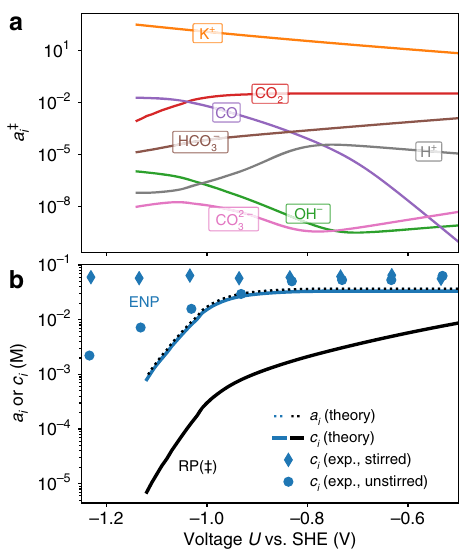
Fig. 6 Voltage dependence of activities and concentrations. a Species activities at the reaction plane (RP, z ) as a function of electrode potential U as predicted by the coupled microkinetic mass transport modeling scheme using CatINT (bulk pH of 6.8). b CO 2 concentration and activity at the reaction plane (RP, z , black) and electroneutrality plane (ENP, 10 nm distance from RP, blue) compared with the ATR-SEIRAS spectroscopic results from ref. 14 , all evaluated at a bulk pH of 7.3. The dots and diamonds denote nonstirred and stirred reaction conditions in the experiments,